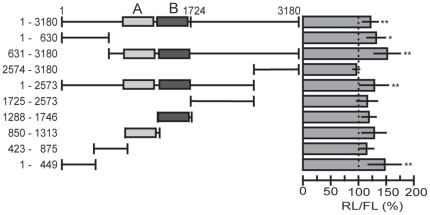
Dicer knock-down indicates that the HNF4A 3′UTR is regulated by miRNAs.To knock-down the Dicer protein, doxycycline (1 µg/ml) was added to the Dicer-kd/2b2 cell line [42] for three or seven days. Two days before luciferase activity was measured, the cells were transiently transfected with reporter constructs. The nomenclature of the constructs is as in Fig. 2. At least three transfection assays were performed for each construct, involving at least two independent plasmid preparations. Each assay was performed in triplicate and a CMV-driven firefly luciferase (FL) was used to control for transfection efficiency. The activity of each construct measured in the presence of Dicer (ethanol added) was used for standardization (100%) and is not shown. The 3xBulgeB and RL-Con reporter plasmids [42] harboring three bulged binding sites for let-7a and lacking any binding sites, respectively, were included as a positive and negative control in each experiment (not shown). The negative elements A and B identified in Fig. S1 are indicated. The p-values were determined using an independent-samples t test. p-values of<0.05 and of <0.01 are indicated by * or **, respectively.